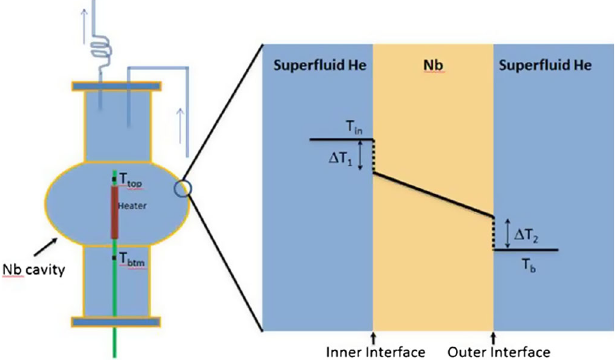
FIG. 1. Schematic of experimental setup to measure the thermal